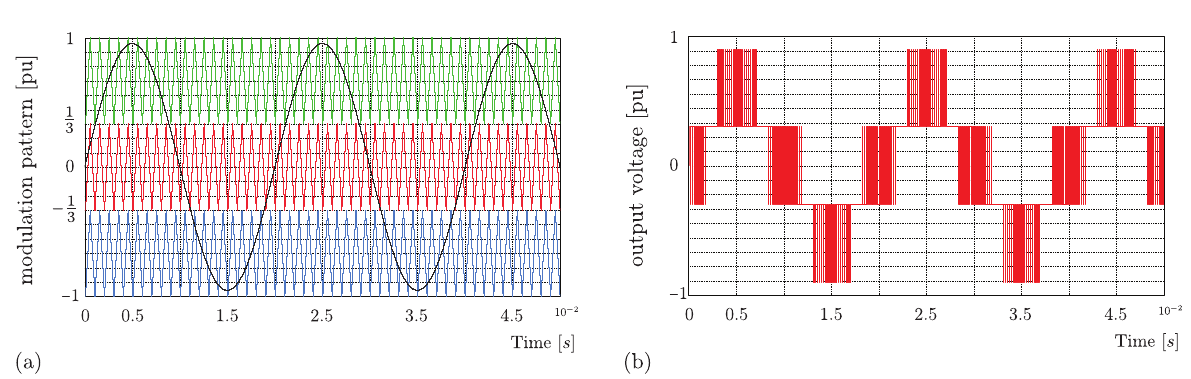
Figure 5. LS-PWM simulation results: ( a ) modulation pattern, ( b ) single-phase output